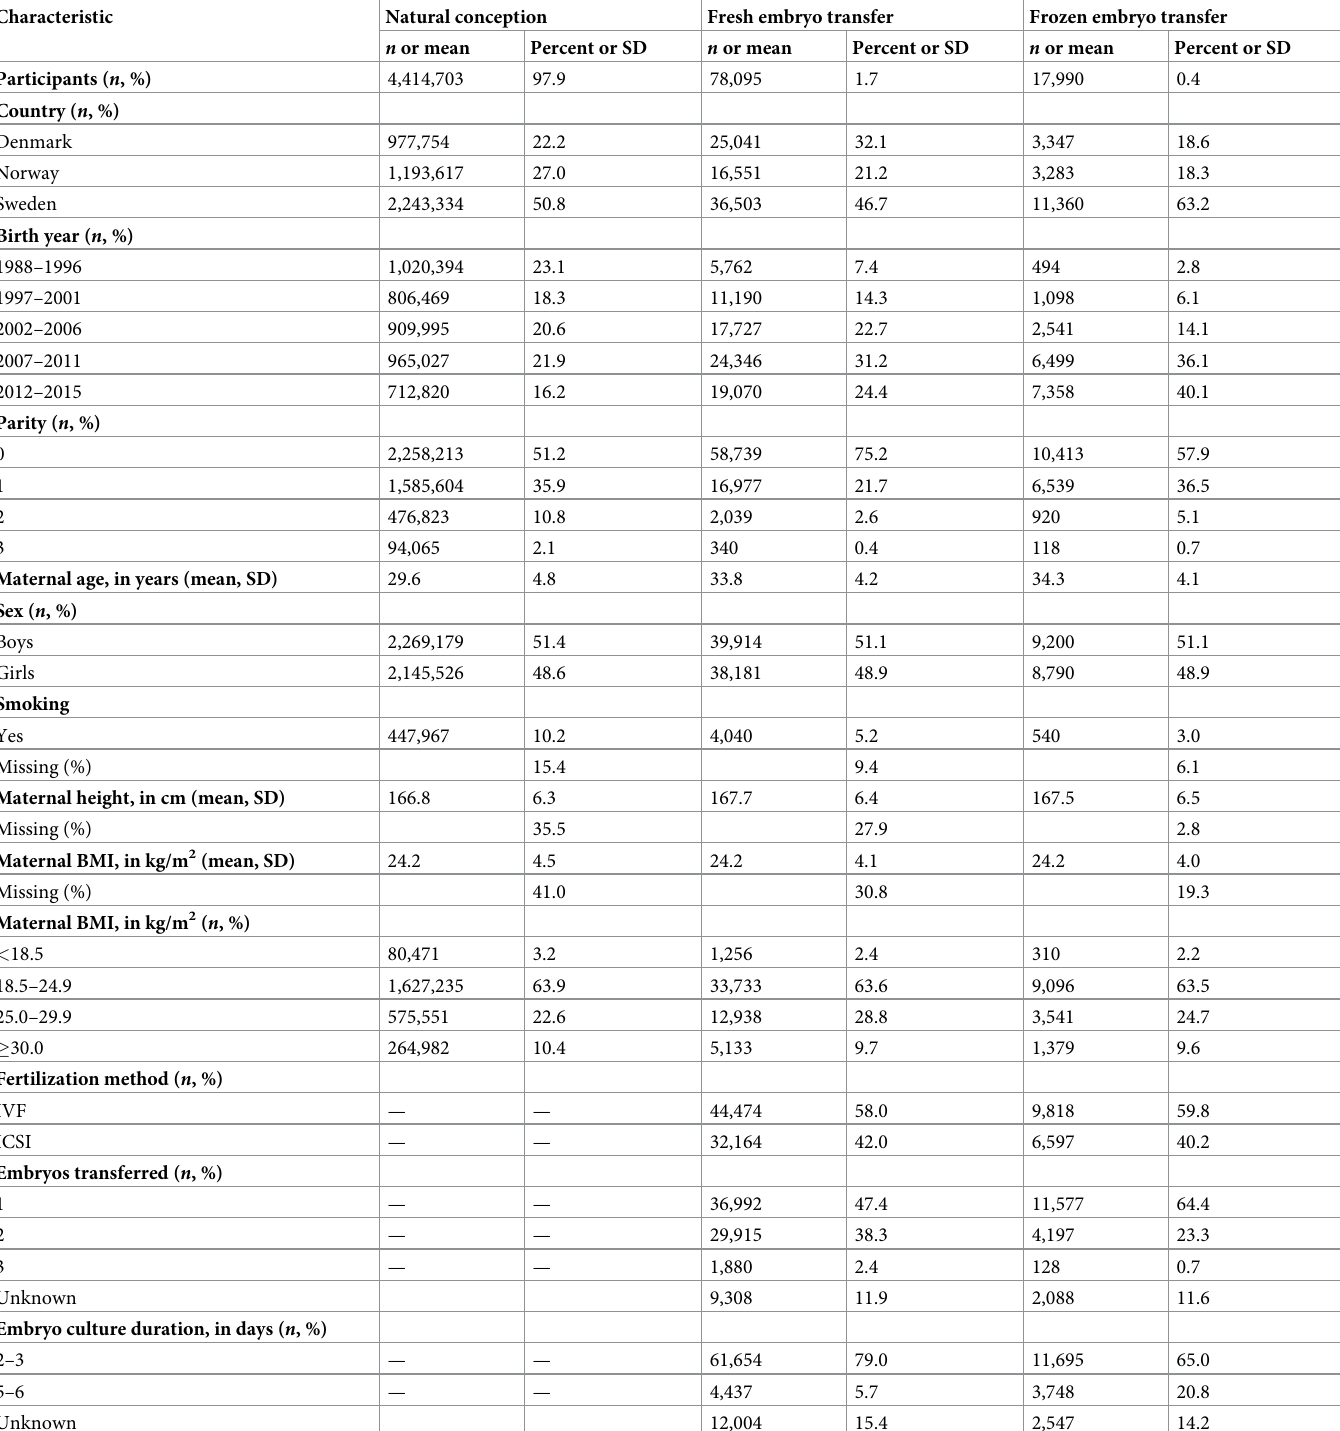
Table 1. Characteristics of the 4,510,790 live-born singletons in main sample